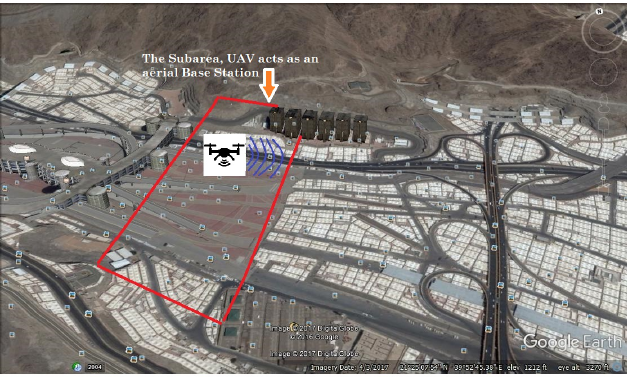
Figure 1. Providing wireless coverage using a single